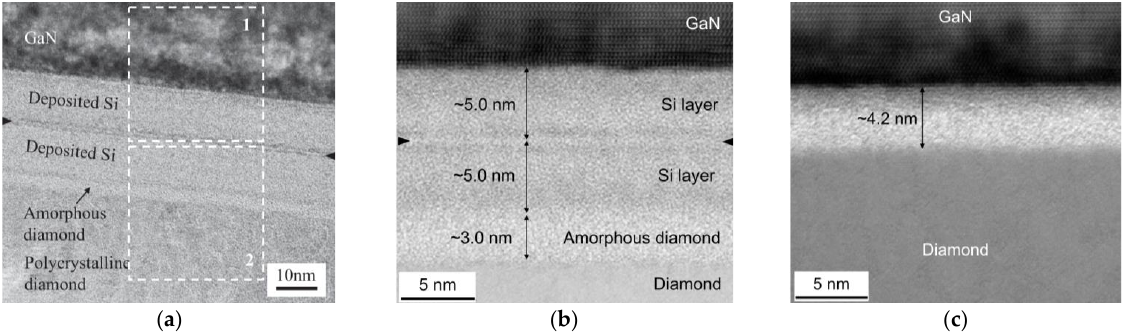
Figure 8. Cross-section TEM image of GaN/diamond interface obtained by SAB at room temperature after ( a ) sputtering a ≈ 12 nm (Reprinted from Scr. Mater., vol. 150, F. Mu et al., "Room temperature GaN-diamond bonding for high-power GaN-on-diamond devices", pp. 148–151 [113], Copyright 2018, with permission from Elsevier) and ( b ) ≈ 5 nm (Reprinted with permission from Z. Cheng et al., “Interfacial Thermal Conductance across Room-Temperature Bonded GaN-Diamond Interfaces for GaN-on-Diamond Devices,” ACS Appl. Mater. Interfaces, vol. 12, pp. 8376–8384, 2020 [115]. Copyright 2020 American Chemical Society) Si nanolayer on both surfaces; ( c ) activating both surfaces with a mixed beam of Si and Ar ions (Reprinted with permission from Z. Cheng et al., GaN-on-Diamond Devices,” ACS Appl. Mater. Interfaces, vol. 12, pp. 8376–8384, 2020